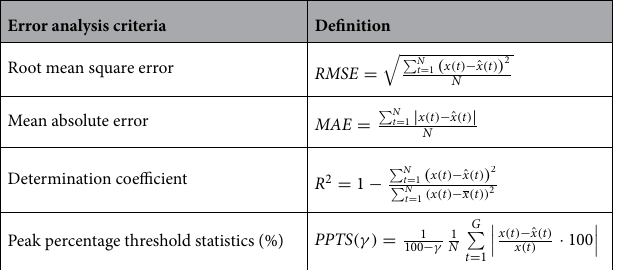
Table 1. Formulas for error analysis criteria. N is the number of samples, x ( t ) is the original series, x ( t ) is the average of the original series and ˆ x ( t ) is the predicted